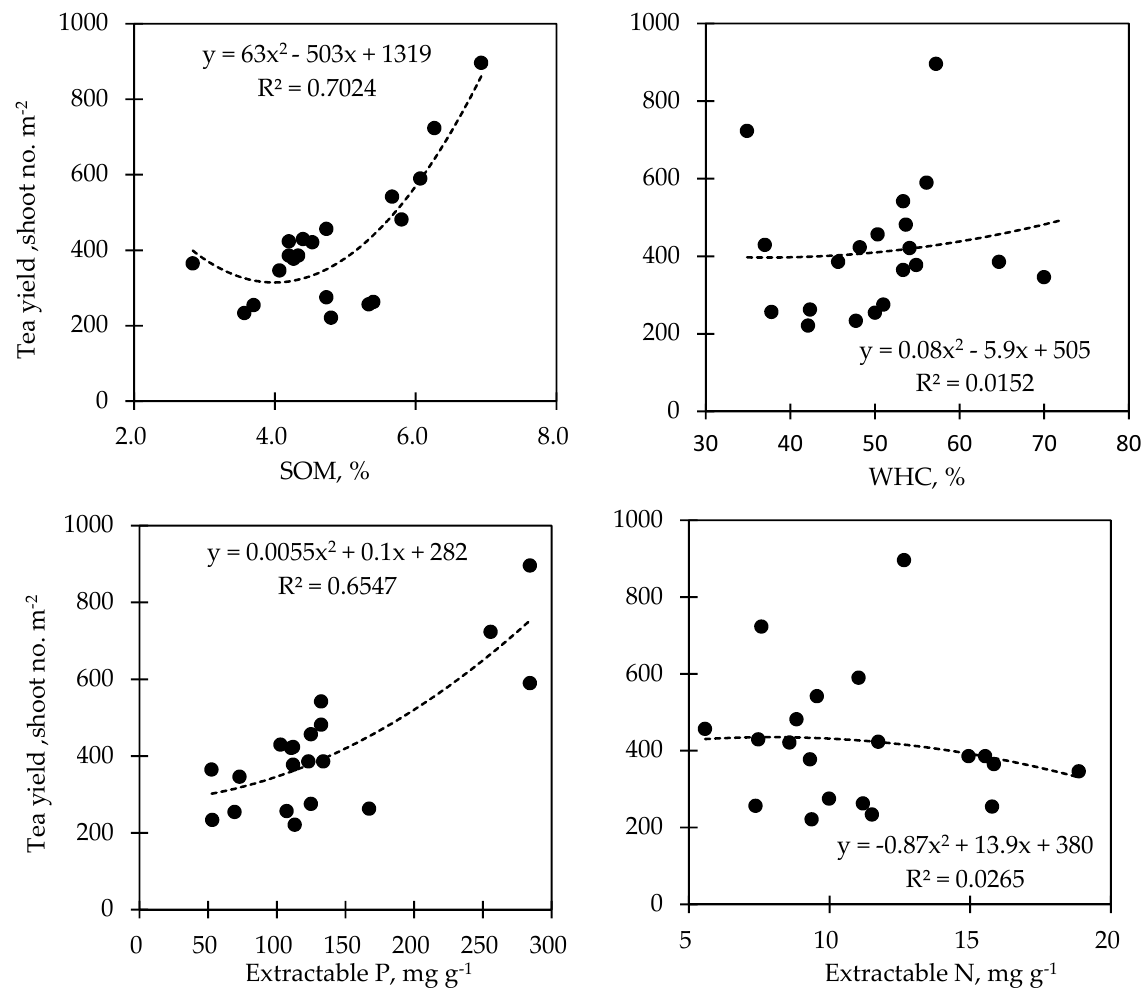
Figure 5. The regression analysis on the relationship between tea yield and soil status.